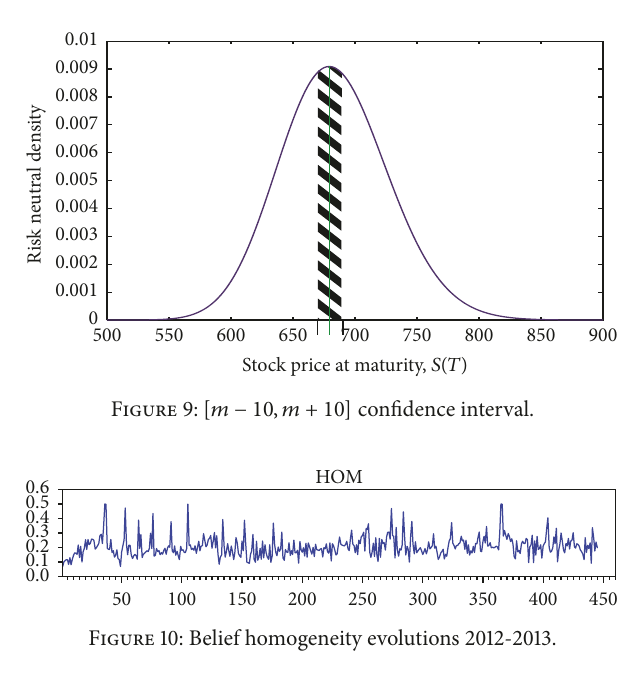
confidence interval ranging from 𝑚 − 10 to 𝑚 + 10 , where 𝑚 is the most expected value.